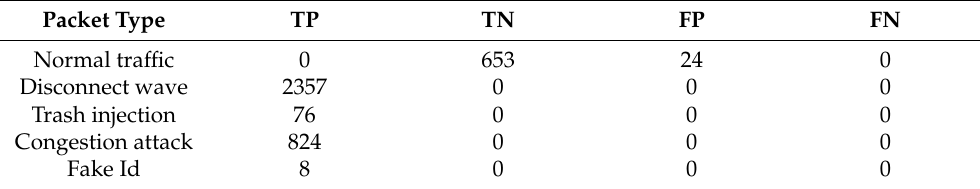
Table 7. Suggested threat detector results by packet type. Packet Type